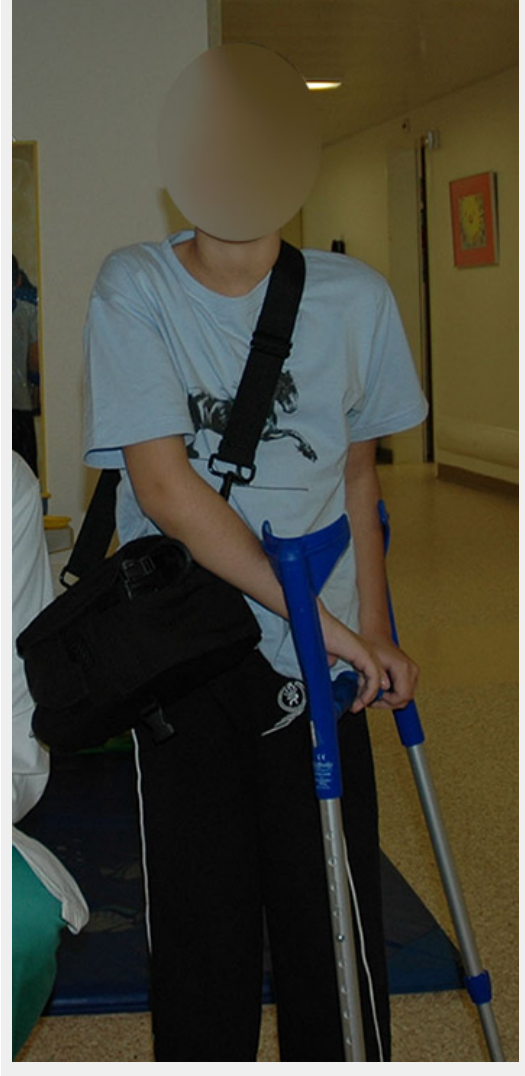
Figure 1 Eight-year old child provided with a Heartware HVAD (third- generation continuous flow device) as a bridge to